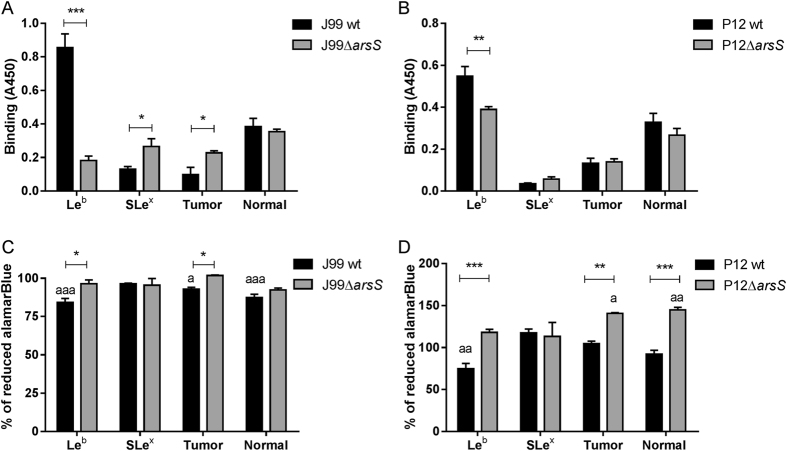
Binding of J99ΔarsS and P12ΔarsS to mucins and glycoconjugates and their viability in response to these mucins and glycoconjugates.(A,B) Binding of bacteria to Leb, SLex, tumor mucin and normal mucin, using the microtiter based assay (n = 4). (C,D) Viability of bacteria after 24 h culture in the presence of Leb, SLex, tumor mucin or normal mucin samples expressed as % change in alamarBlue reduction (n = 6). Results are shown as percent of reduced alamarBlue compared to each bacteria cultured without glycoconjugates/mucins, ap ≤ 0.05, aap ≤ 0.01, aaap ≤ 0.001 ANOVA with Dunnett’s post hoc test, *p ≤ 0.05 **p ≤ 0.01, ***p ≤ 0.001 Student’s t-test. All values are mean ± S.E.M. The results in the graphs have been reproduced at least twice with the same outcome.